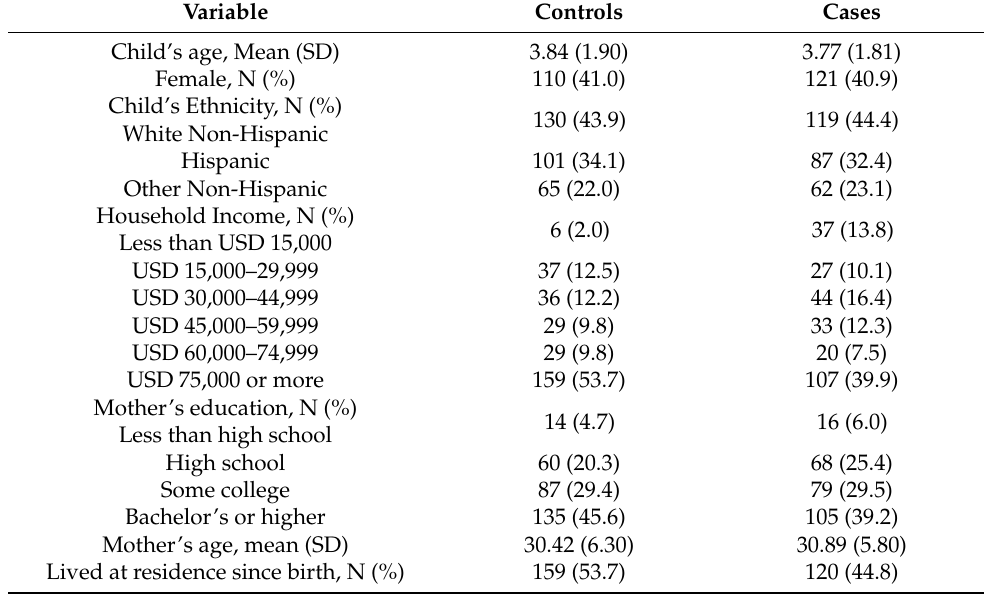
Table 5. Characteristics of childhood leukemia cases (n = 268) and controls (n = 296) with measure- ments of chemicals in house dust in the CCLS. Variable Controls